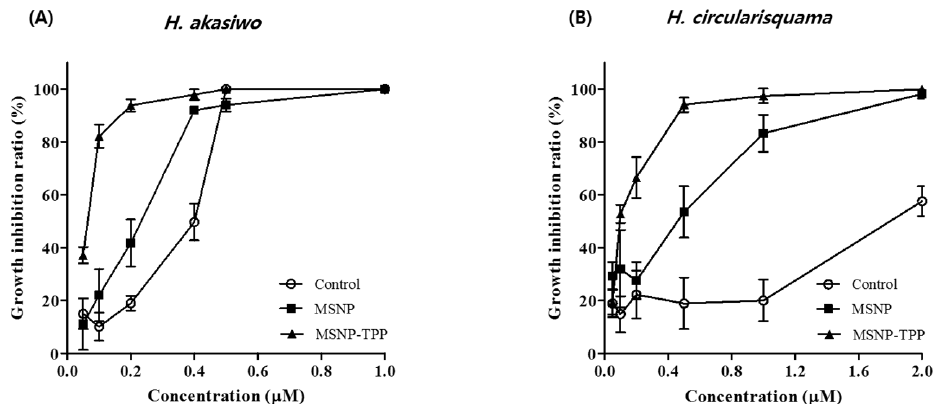
Figure 4. Algicidal activity of DP92 in MSNP and TPP-MSNP against ( A ) H. akashiwo, ( B ) H. circularisquama. Data are presented as mean ± SD ( n = 3). Table 4. IC 50 values of DP92-loaded MSNP or TPP-MSNP in HABs. Data are presented as mean ± SD ( n = 3). * ,# p < 0.01 compared with the control group. IC 50 ( µ M)